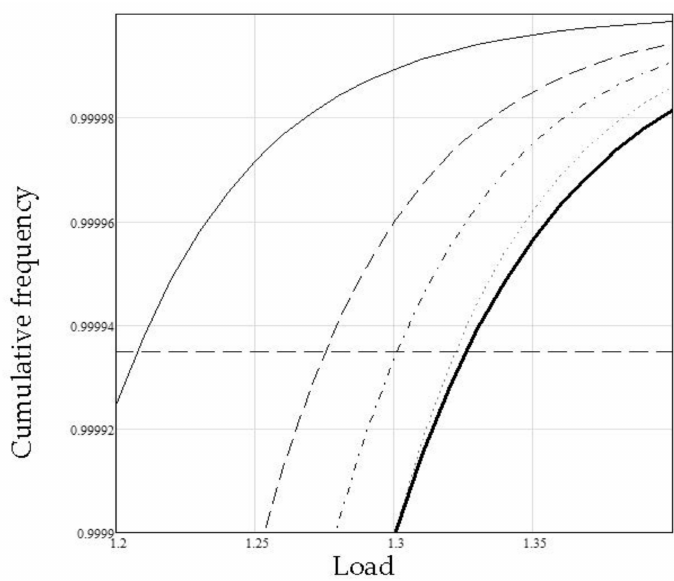
Figure 4. Same as Figure 1 with different